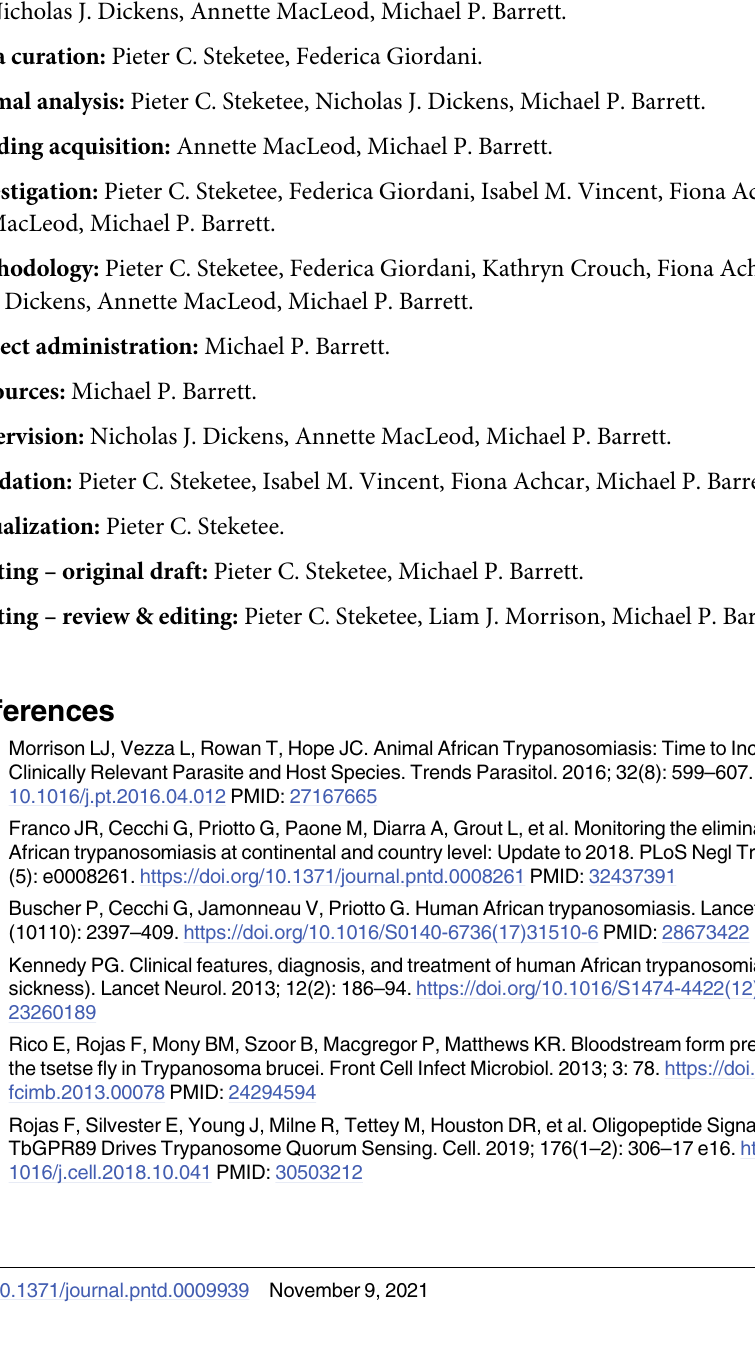
S4 Table. Excel file containing outputs of the statistical analyses of the metabolomics data.